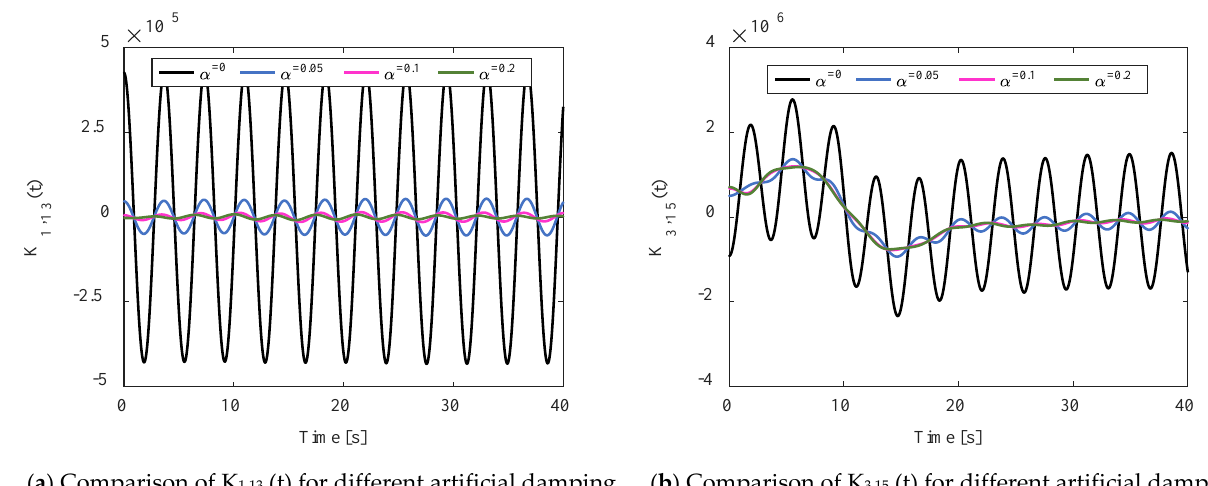
( a ) Comparison of K 1,13 (t) for different artificial damping ratios